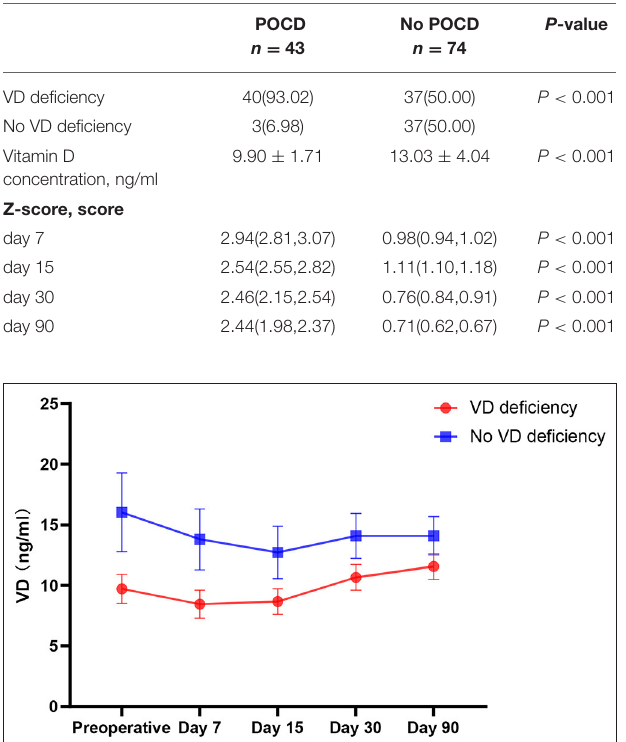
FIGURE 3 | Trends in Vitamin D.